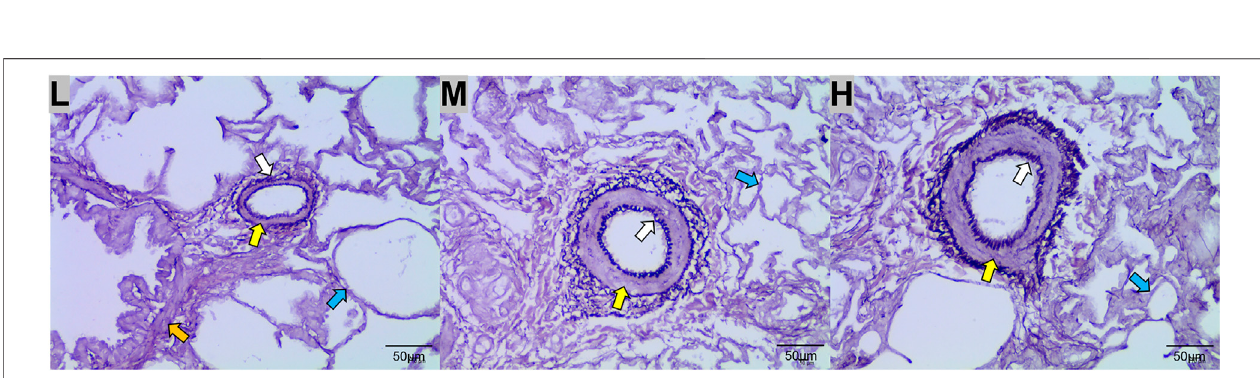
FIGURE 3 | Weigert resorcinol magenta (WRM) staining of the lungs of Tibetan sheep at low (L) , middle (M), and high (H) altitudes at 400x fi eld of view. Yellow arrows indicate arterioles, orange arrows indicate terminal bronchioles, blue arrows indicate alveoli, and white arrows indicate elastic fi bers.